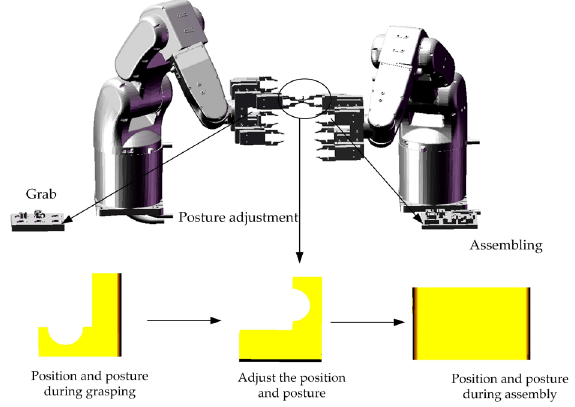
Figure 6. The assembly mode of two-arm cooperation robot.